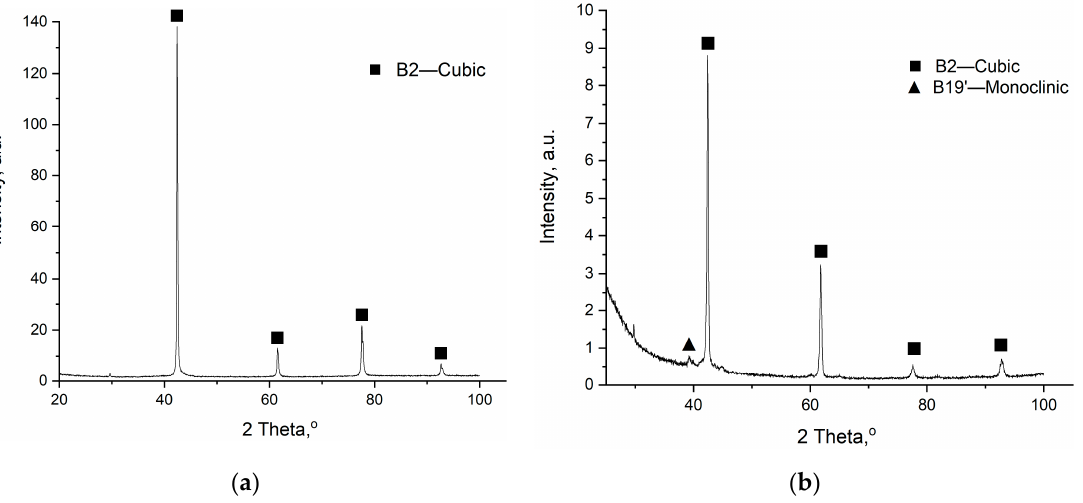
Figure 7. XRD patterns. ( a ) Initial powder of TiNi alloy; ( b ) A lattice structure sample fabricated by the SLM technique.